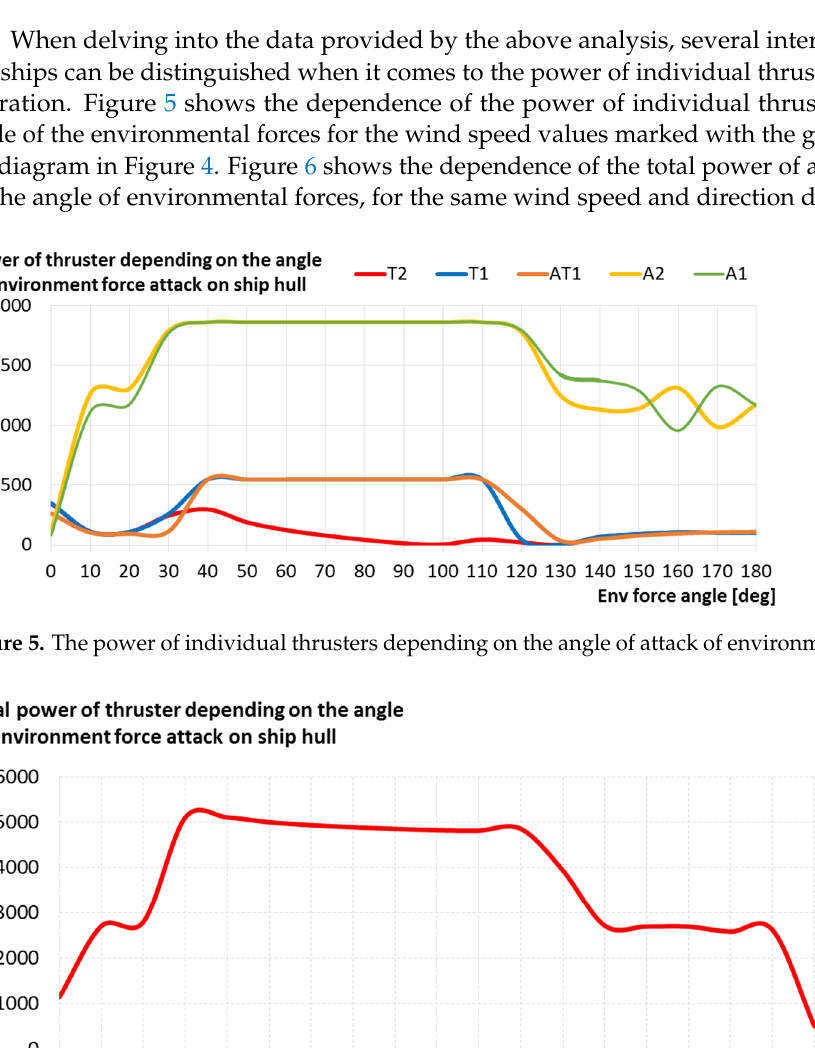
Figure 4. The result of the capability plot analysis for a conventional positioning system.